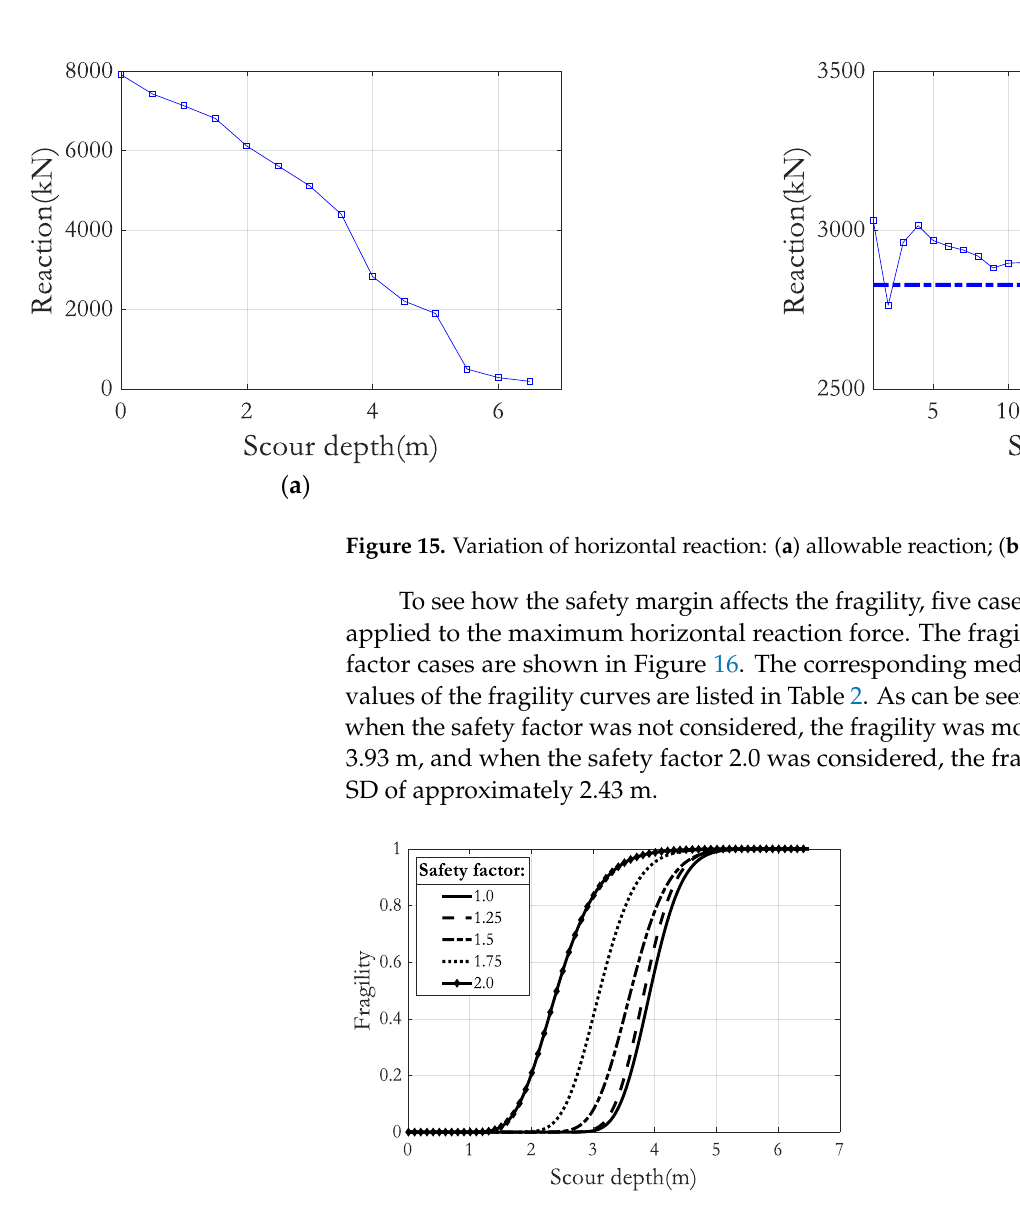
( b ) Figure 13. Variation of pull-out reaction: ( a ) allowable reaction; ( b ) reaction at SD = 6.5 cm. ( a ) ( b ) Figure 14. Variation of compressive reaction: ( a ) allowable reaction; ( b ) reaction at SD = 6.5 cm. The results of horizontal force analysis are given in Figure 15. As shown in Figure